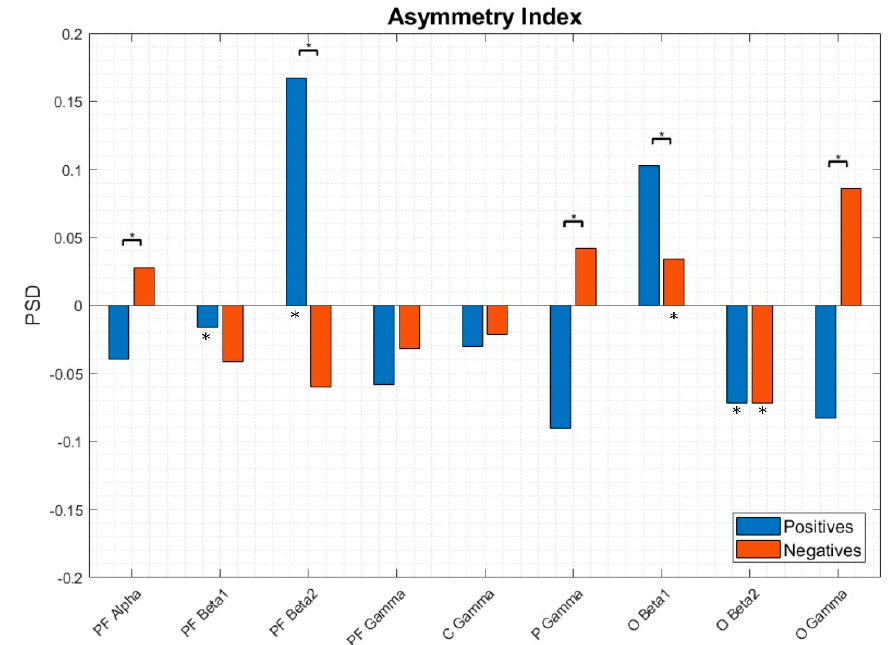
Figure 4. AI for the nine studied frequency-location pairs at positive and negative emotions for all subjects. The bracket with the asterisk above, which joins two bars of the histogram, indicates those pairs that have shown significant differences ( p -value < 0.05) between the positive-negative conditions. Asterisks on the bars indicate significant differences ( p -value < 0.05) between interhemispheric, intra-condition (positive-positive or negative-negative).